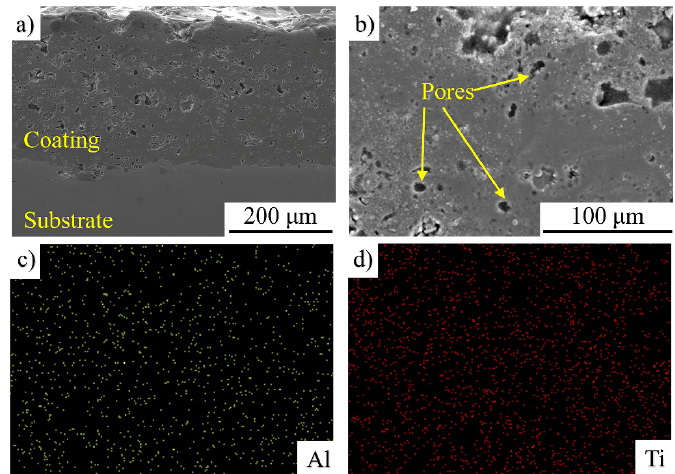
Figure 7. The cross ‐ sectional micrographs and Al and Ti elemental EDS maps of the coating: ( a ) the microstructure of the interface, ( b – d ) micrograph and corresponding EDS map of the coating.